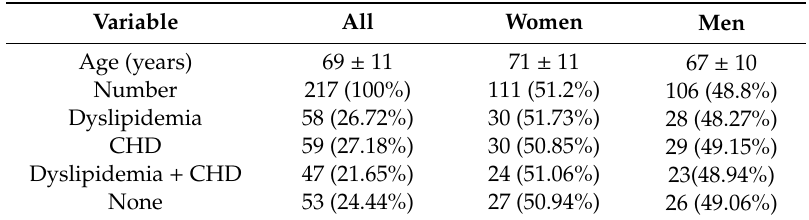
Figure 2. Prescription patterns of statins by gender. In terms of diabetes management, the patients were prescribed: 